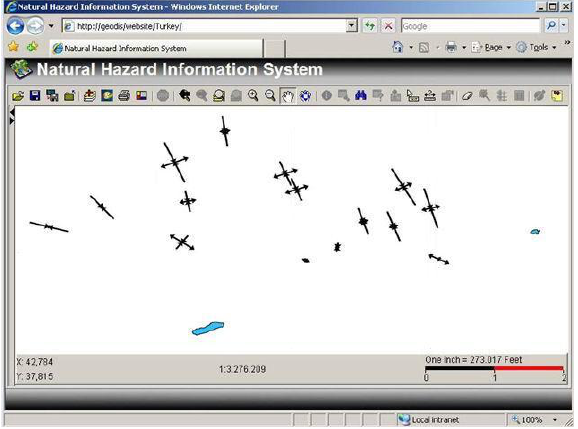
Figure 4. Output map showing strain